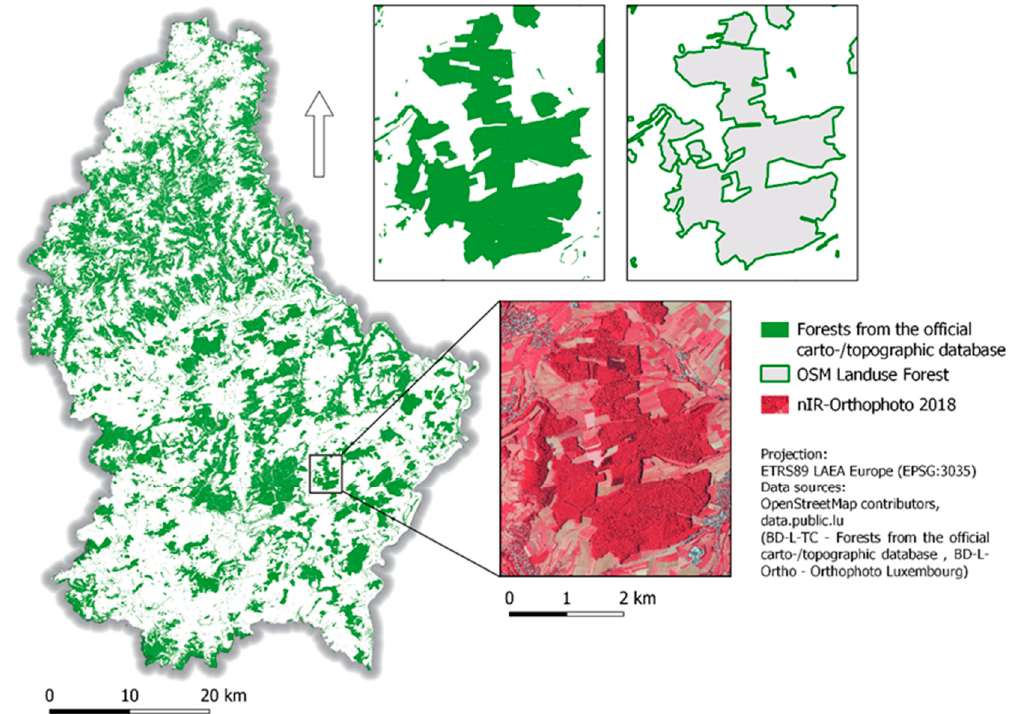
Figure 1. Overview of the forests from the official carto-/topographic database in the Grand Duchy of Luxembourg and close-ups of a forest area from the database compared to OSM Landuse Forest and the nIR-orthophoto from 2018.